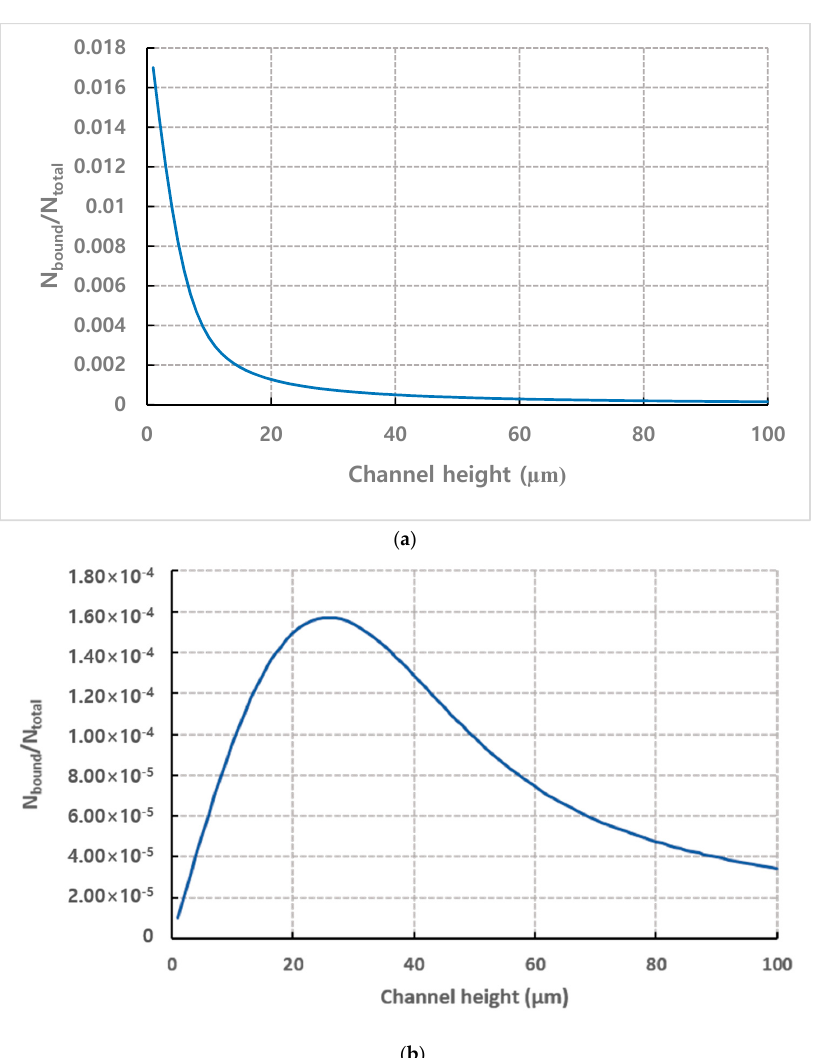
Figure 16. N bound / N total according to the channel height for ( a ) observation position = 0 mm ( b ) observation position = 35 mm.